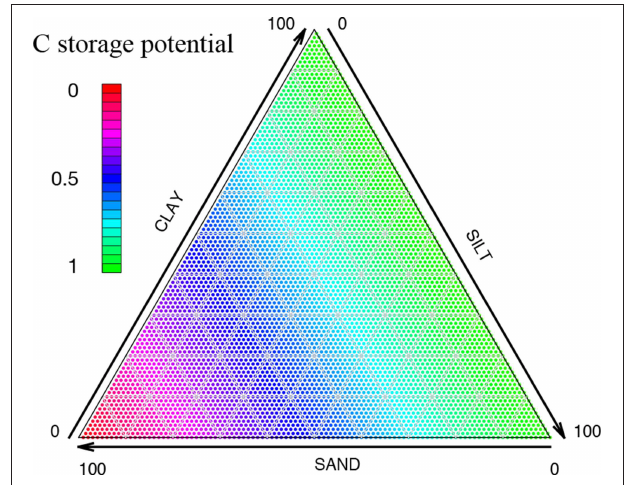
FIGURE 5 | Storage potential I SOC for organic carbon is a direct function of soil texture according to Equation (12).